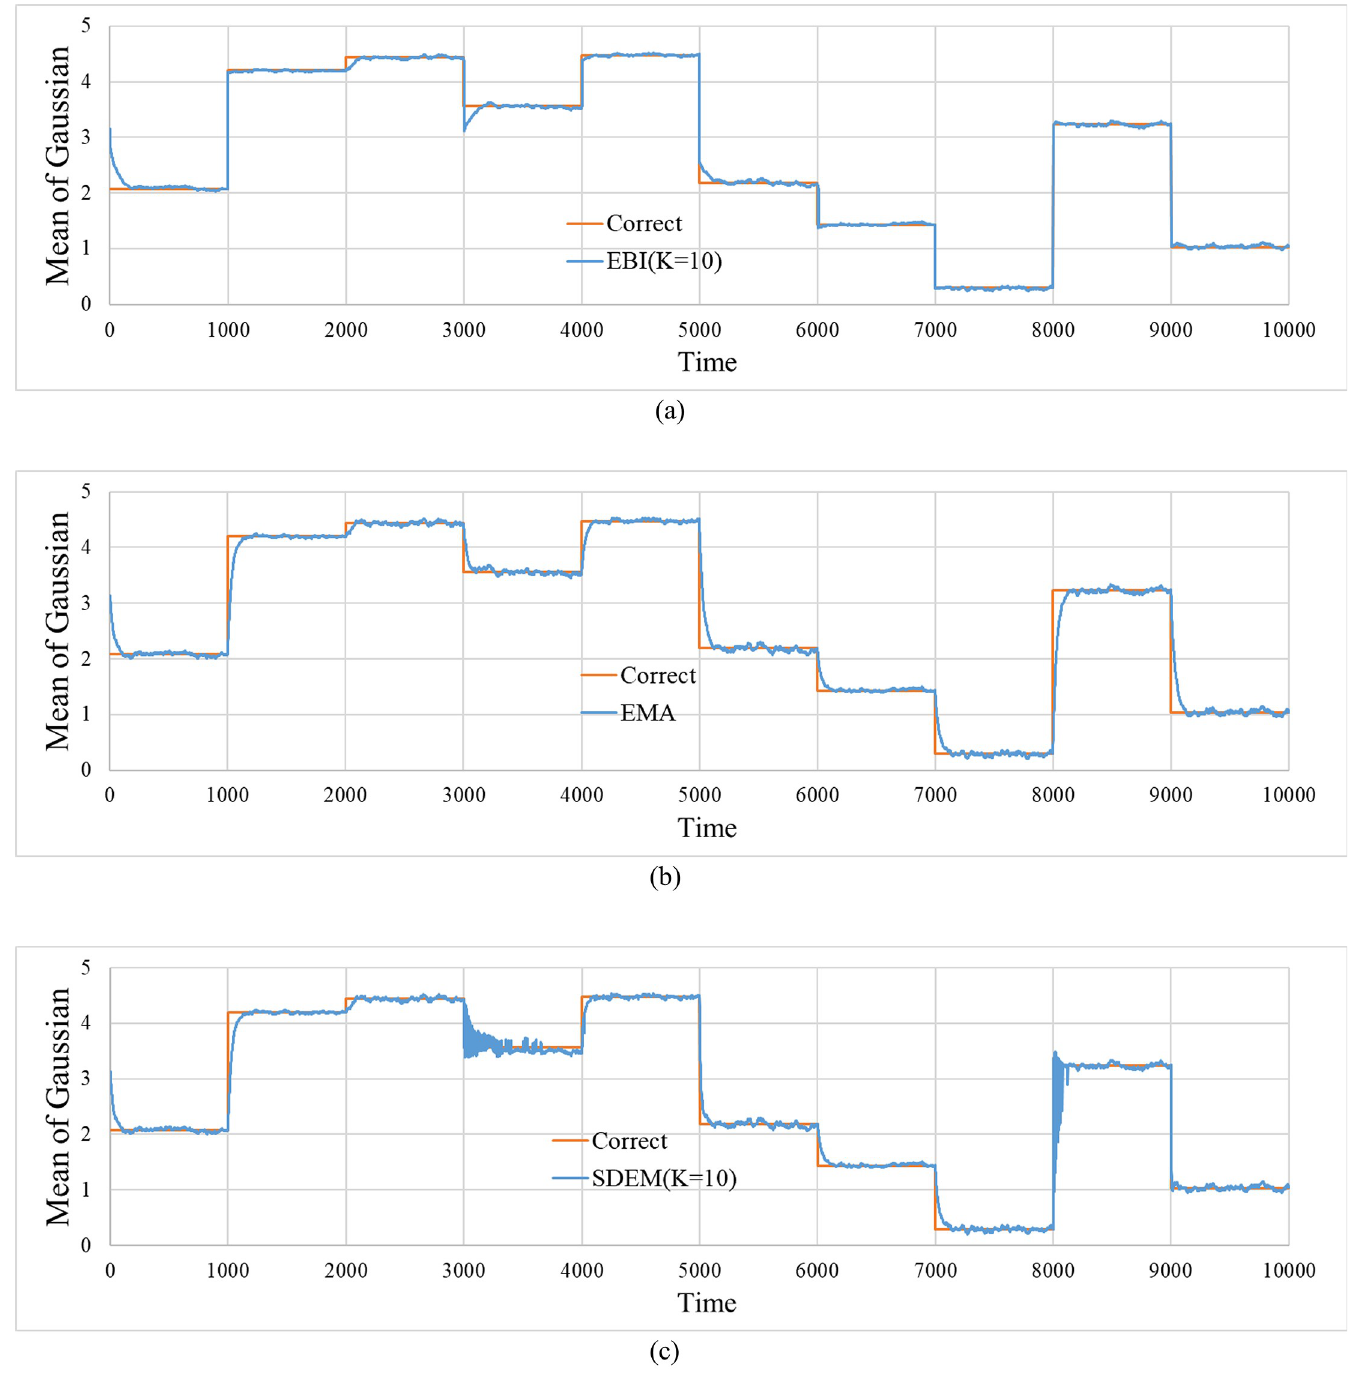
Fig 5. Time progress of the estimated values for the mean of Gaussian. The figure includes the correct mean. (a) Estimated values by EBI. ( α , m , K )= (0.03,0.0,10). (b) Estimated values by EMA. β = 0.03. (c) Estimated values by SDEM. ( β , K ) = (0.03,10). https://doi.org/10.1371/journal.pone.0233559.g005 In the results shown above, the EBI simulations were performed for only m = 0. The results of EBI when m is changed are shown below. The values of α and m were shifted, with incre- ments of 0.05 and 0.1 in the interval [0.05, 0.5] and [–2, 2], respectively, and simulations were